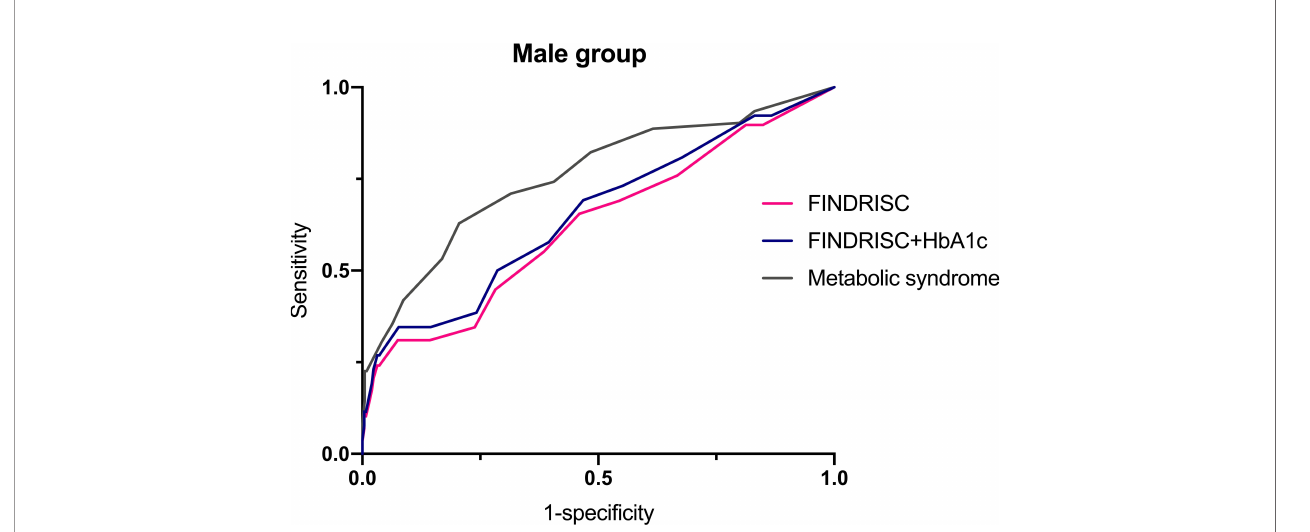
FIGURE 2 | FINDRISC area under ROC curve (AUC) for identifying T2DM in male populations.